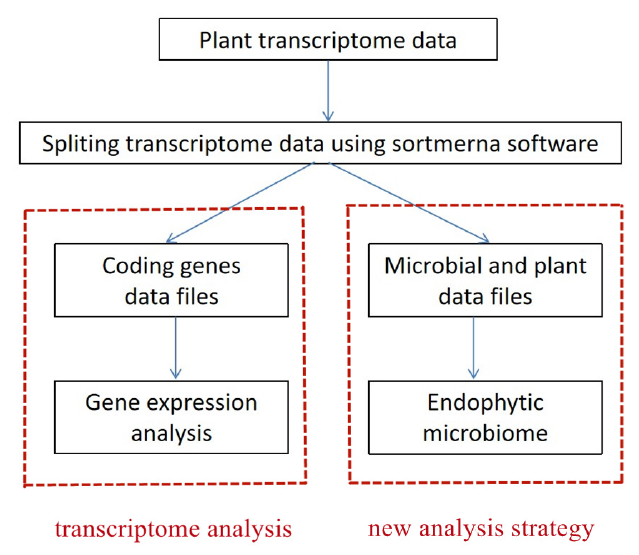
Figure 1. Schematic diagram of the new analysis strategy.